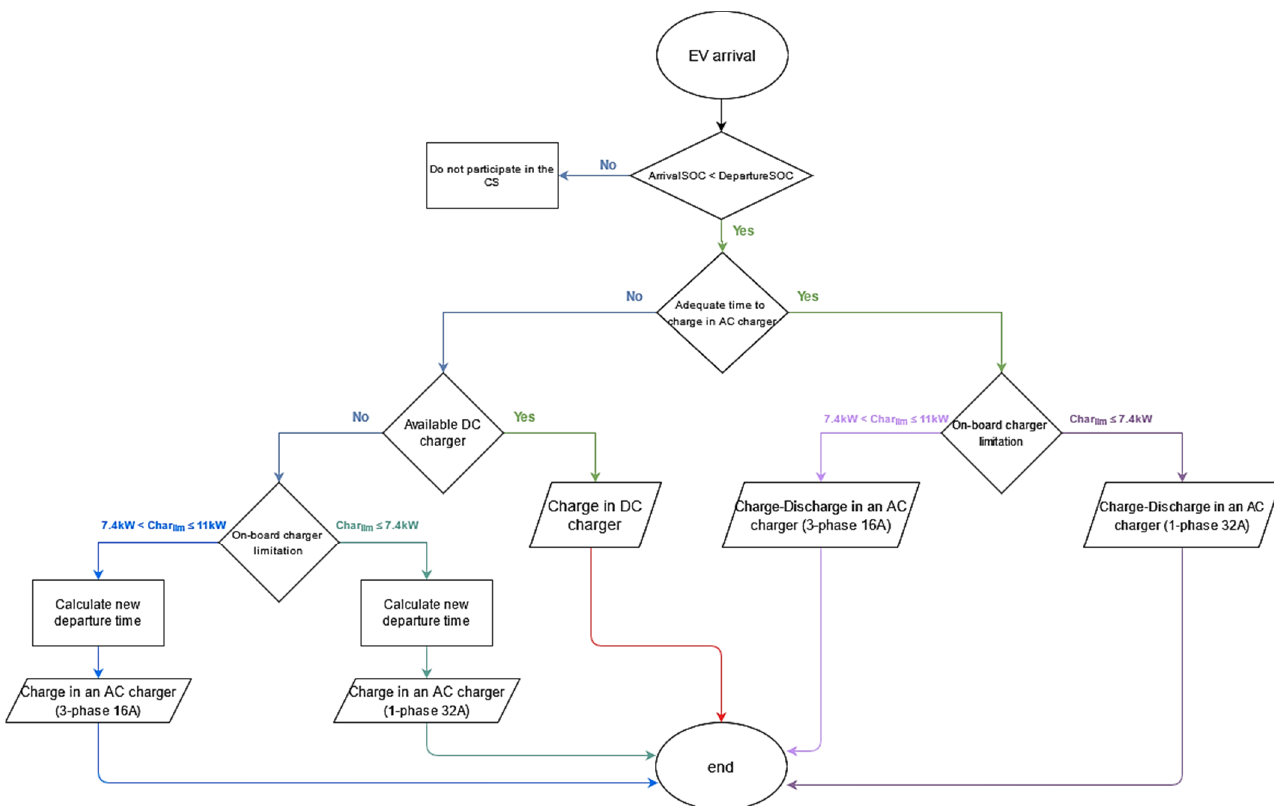
Figure 3. Flow chart for choosing type of charger.